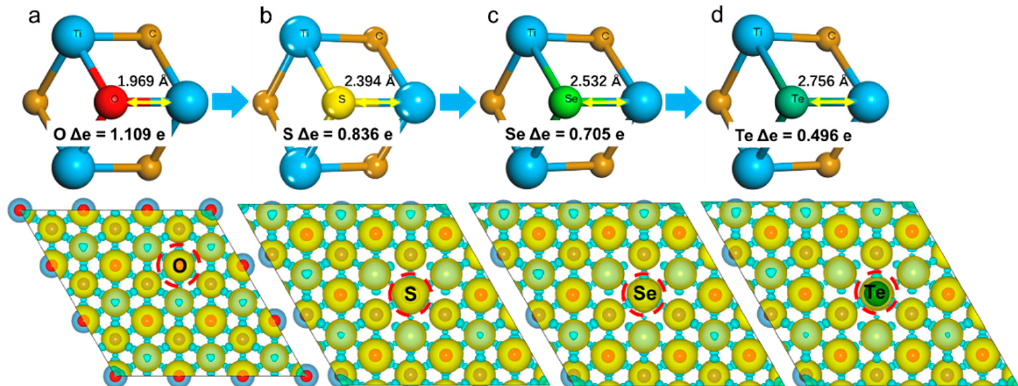
Figure 3. Bond length, charge transfer, and first-order differential charge density. ( a ) Top image shows the local crystal structure of the hydrogen adsorption site O of 2D-Ti 3 C 2 O 2 , bond length, and charge transfer in O-Ti; bottom image shows the first-order deformation charge density diagram; ( b – d ) top images show the 2D-Ti 27 C 18 O 17 X 1 local crystal structure of hydrogen adsorption site X, bond length, and charge transfer in Ti-X; the bottom images show the corresponding deformation charge density diagrams; (red dotted circles hinting the charge distribution of the active sites O or Te of HER catalyst).